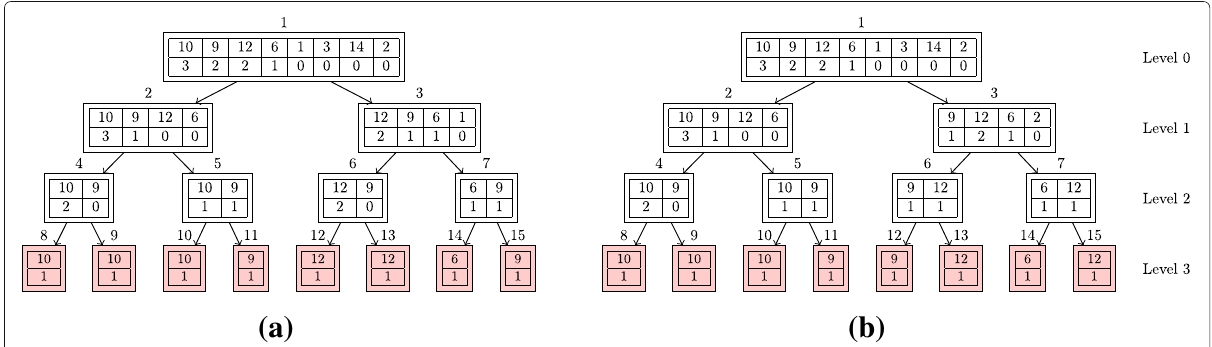
Fig. 4 An example of the redistribution for x = [10,9,12,6,1,3,14,2] and m = [4,2,1,1,0,0,0,0] using the original and improved (new) redistribute. The original redistribution always sorts the number of copies vector (bottom vector) in a descending order, while this is not required in the new redistribution (e.g., see node no. 3). a Original. b New